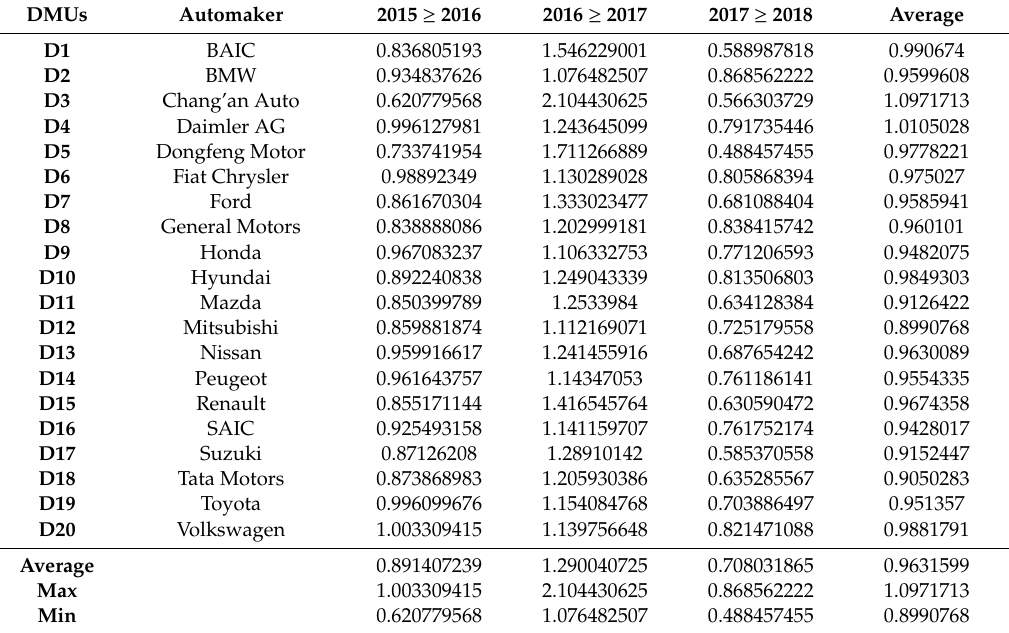
Table 5. Frontier-shift index of the